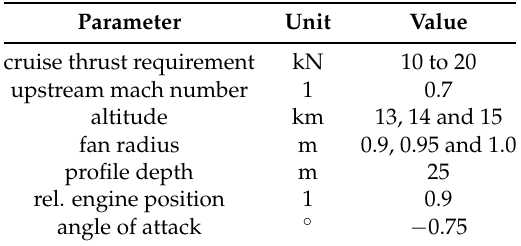
Table 1. Setup and boundary